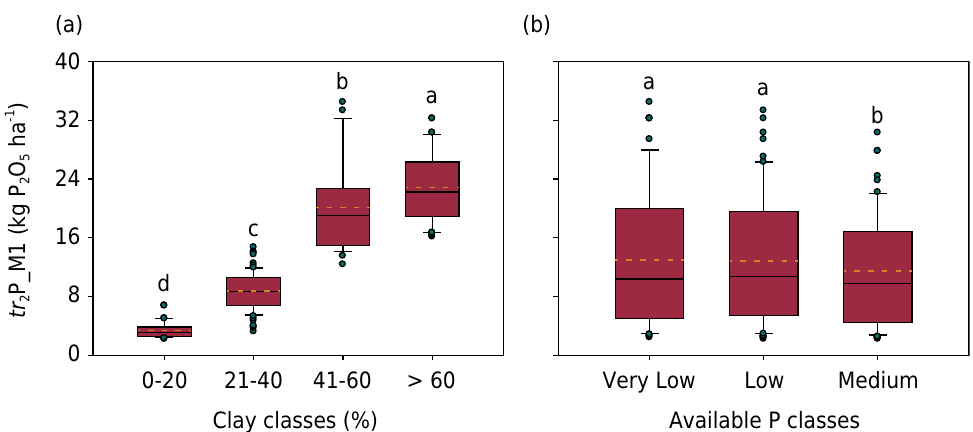
Figure 3. Grouping of phosphorus buffer capacity values ( tr 2 P_M1) according to clay classes (a) and phosphorus availability classes (b). In both figures, different letters indicate significant statistical differences by the Tukey test (p<0.05). Orange dotted lines represent the averages. Green dots represent outliers.